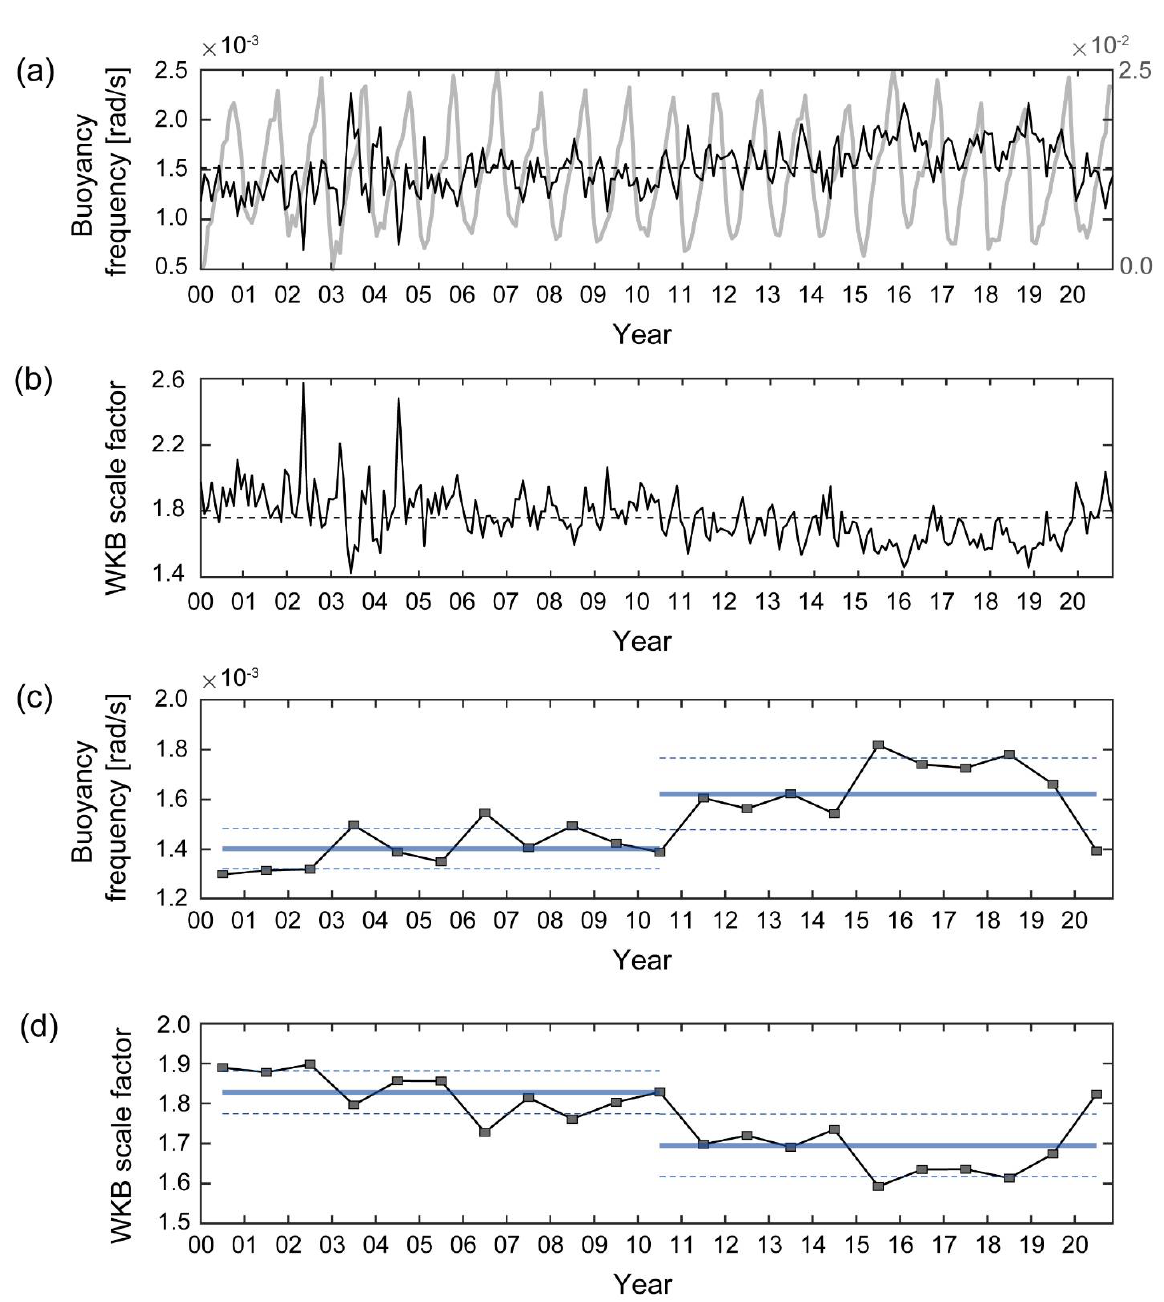
Figure 4. Time series of ( a ) monthly and ( c ) annual mean Buoyancy frequencies at 50 m (grey line, right y -axis in ( a ) only) and 400 m (black lines and squares, left y -axis) derived from EN4, ( b ) monthly and ( d ) annual mean Wentzel-Kramers-Brillouin (WKB) scale factors at 400 m. Dashed lines in ( a ) and ( b ) indicate temporal means for 400 m. Blue thick solid and thin dashed lines in ( c ) and ( d ) represent decadal means and their standard deviations for 2000s (from 2000 to 2010) and 2010s (from 2010 to 2020), respectively.